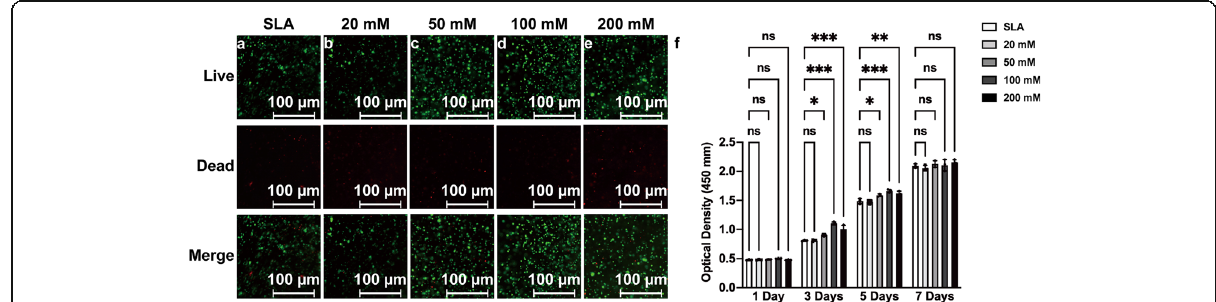
Fig. 7 Fluorescence microscopy images of live/dead staining of BMSCs cultured on SLA surfaces ( a ) and SLA discs treated with 20 mM ( b ), 50 mM ( c ), 100 mM ( d ), or 200 mM ( e ) sodium bicarbonate after 72 h of cell seeding. Proliferation of BMSCs cultured in each group for 1, 3, 5, and 7 days determined by CCK-8 assays ( f ). Data are presented as the mean ± standard deviation ( n = 3, * P < 0.05; ** P < 0.01; *** P <